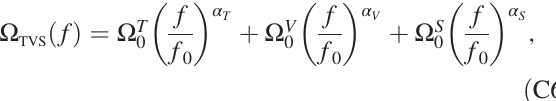
, we N , we give equal GR